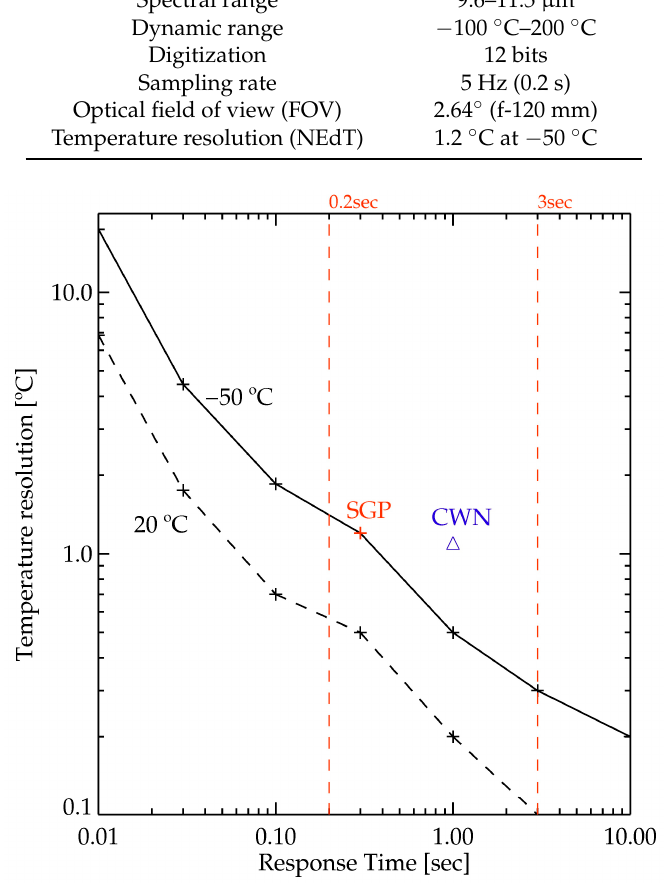
Figure 2. The temperature resolution as a function of the response time [17]. The solid and dashed black lines denote the radiation source temperatures of − 50 ° C and 20 ° C, respectively. The red plus indicates the NEdT of the SGP IRT (Table 1). The red vertical lines indicate two different sampling rates: the original 0.2-s rate, and the reduced 3-s rate. The blue triangle represents the NEdT specification of IRT used for the previous study [9]: 1.1 K at − 50 ° C with a 1-s response time.